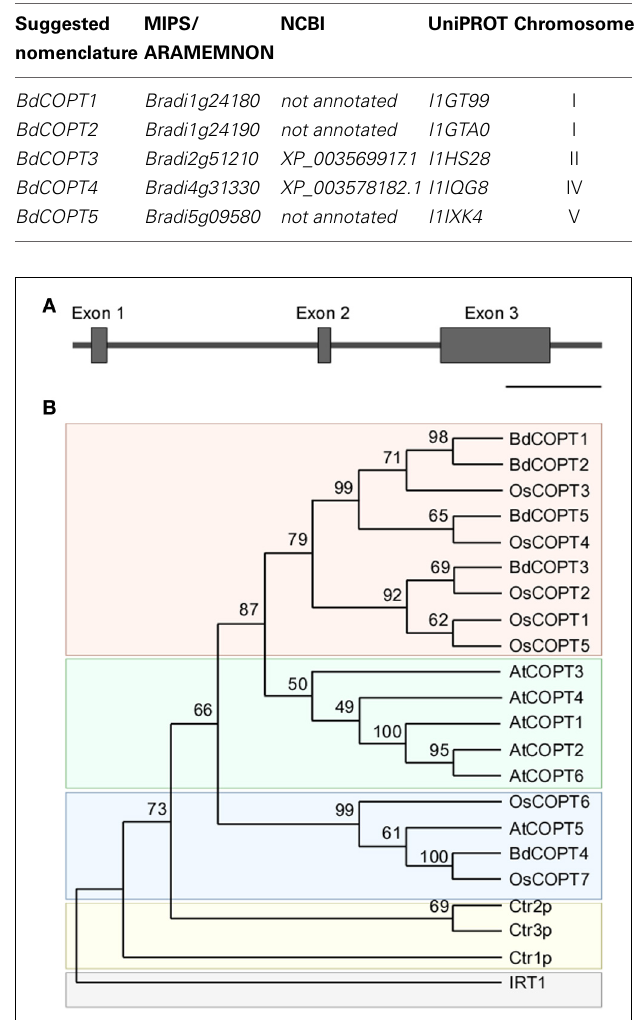
Table 1 | The proposed nomenclature and accession numbers of putative brachypodium COPT transporters annotated at different databases.